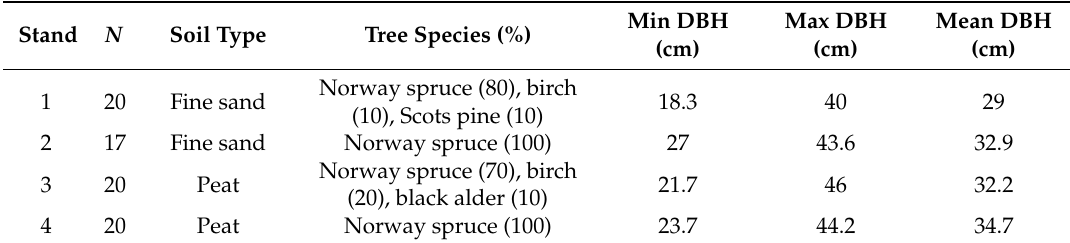
Table 1. Sample size, soil type, species composition, and DBH (diameter at breast height) of the pulled Norway spruce ( Picea abies L.) trees in tested